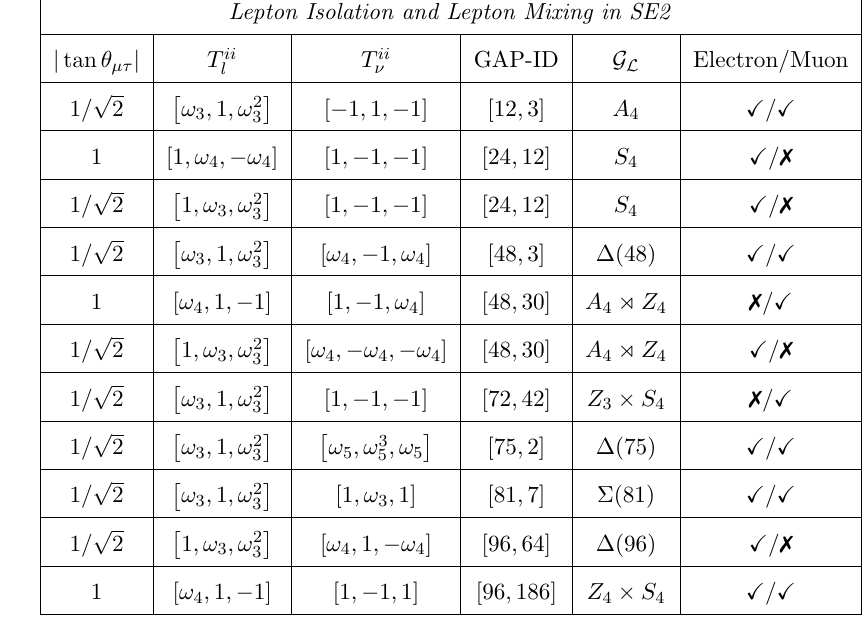
Table 10 . Flavour symmetries G L controlling electron and/or muon isolation patterns (cid:21) [ e;(cid:22) ]